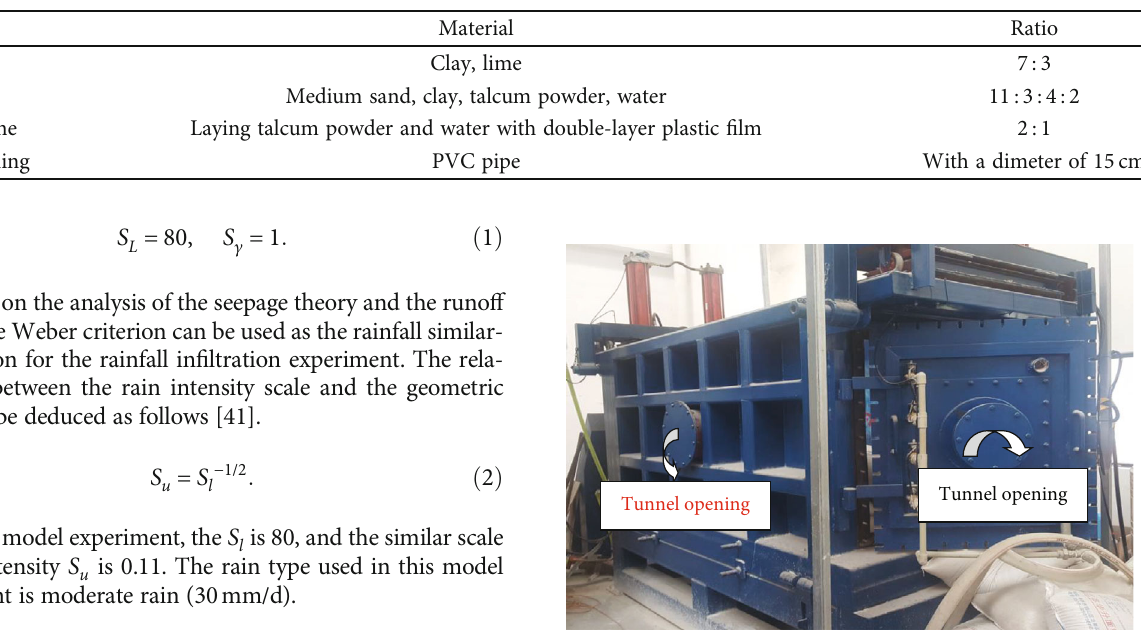
Table 1: The proportion of similar soil materials.